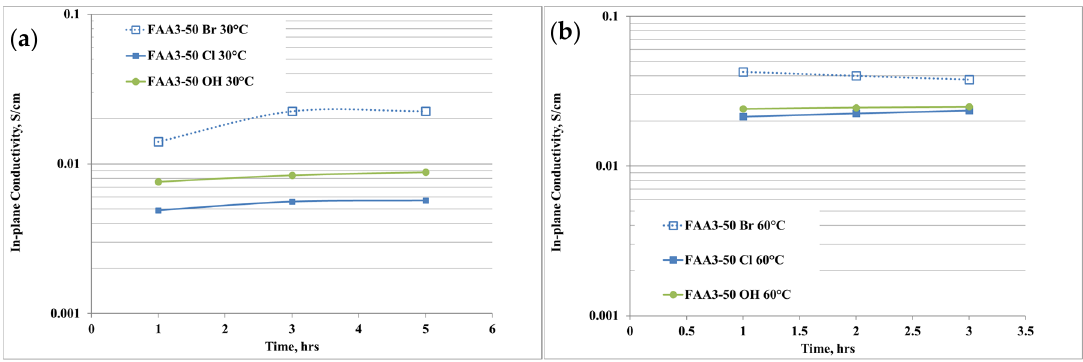
Figure 4. ( a , b ) Anion conductivity of the membrane with different counter-ions for the quaternary ammonium at ( a ) 30 °C, ( b ) 60 °C.